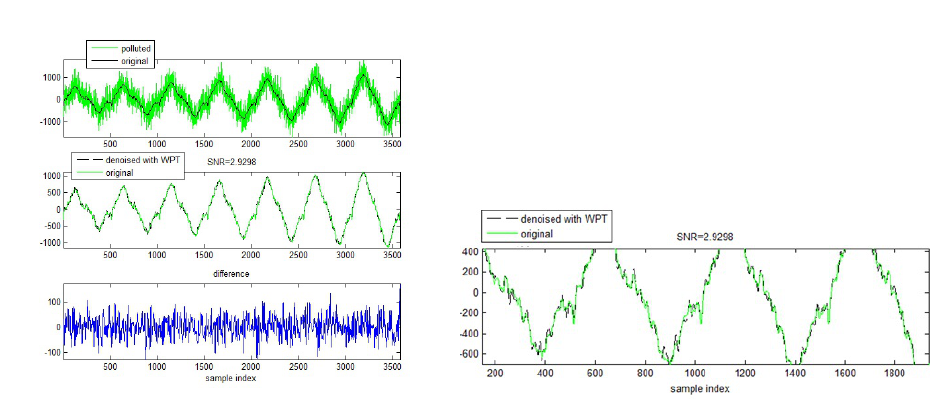
Figure 10. Ascending slope, M = 0.06, most sig- nificant noise. Top - Analysed signals (original and polluted). Middle – original signal and sig- nal denoised with WPT. Bottom – di ff erence be- tween original signal and signal denoised with WPT.